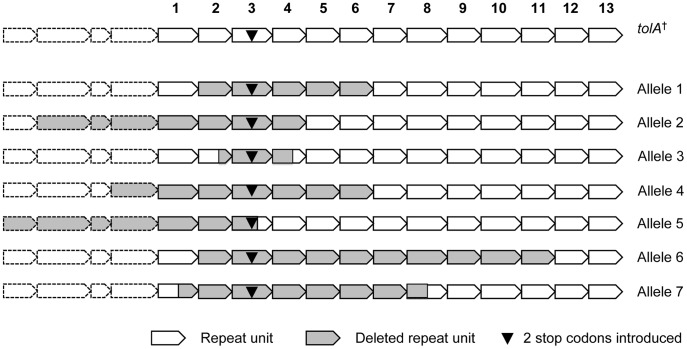
Schematic diagram of tolA TR deletions.Different tolA TR deletions obtained from MG1655 tolA† which carries a nonfunctional tolA gene with a TR unit with two stop codons are shown. A total of 39 clones with TR deletions were sequenced, among which seven different TR deletions were found. The 13 TR units that have been recognized in previous studies [17], [18] are numbered. In some cases, the deletions extended in the region upstream of TR1 which contains some less well conserved TR units (dotted lines) (see main text). The differences of unit size were shown in proportion. Allele 1 was found 33 times, both under SDS and DOC selection, and in the recA, uvrD and mutS backgrounds. All other alleles were found only once. Alleles 2 and 3 were recovered from the strain without additional mutations in recombinational pathways under 0.6 M NaCl pH 5.0 and DOC stress, respectively. Alleles 4 and 5 were recovered from the recA background under SDS stress, and alleles 6 and 7 from the uvrD background under SDS stress.